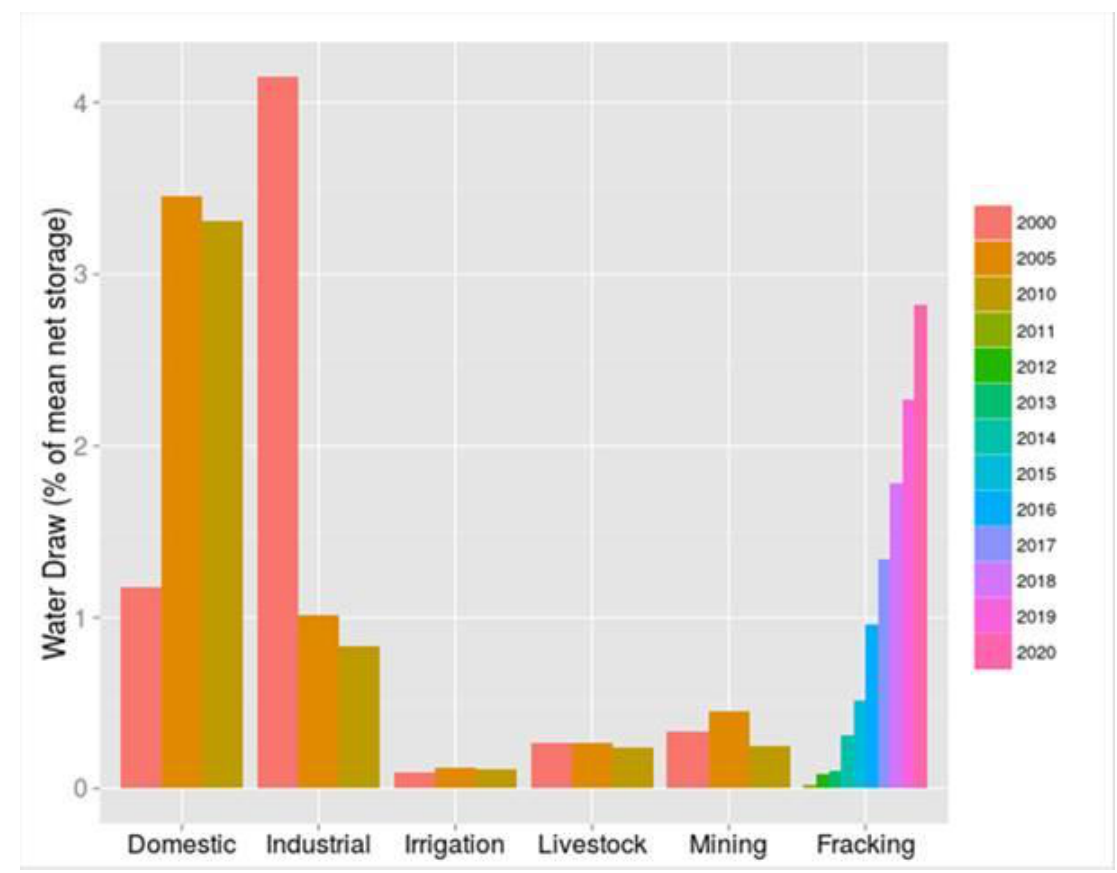
Figure 6. Freshwater demand across six sectors within the Muskingum River Watershed, south-east Ohio between 2000 and modelled out to 2020.